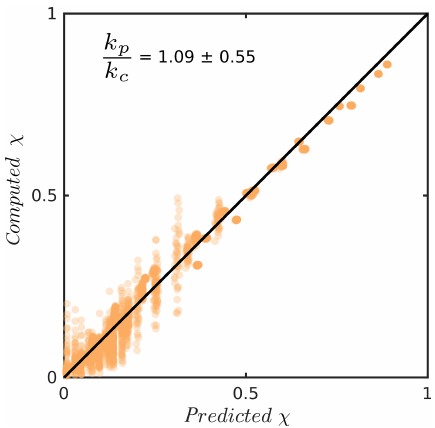
Figure 7. Parity plot of predicted versus computed hydraulic effi- ciency χ for a total of 2554 fractures with an l c /L ratio of 1 / 16. The black line indicates the location of perfect parity. Inlet data give the mean and standard deviation of predicted ( k p ) over computed ( k c ) permeabilities that correspond to all data points in the